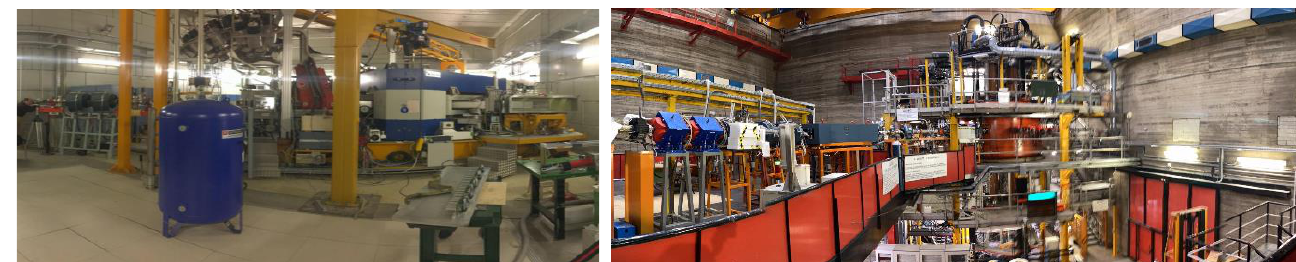
Figure 1. Pictures of MAGNEX ( left ) and of the superconducting cyclotron (CS, right ) at the Laboratori Nazionali del Sud.